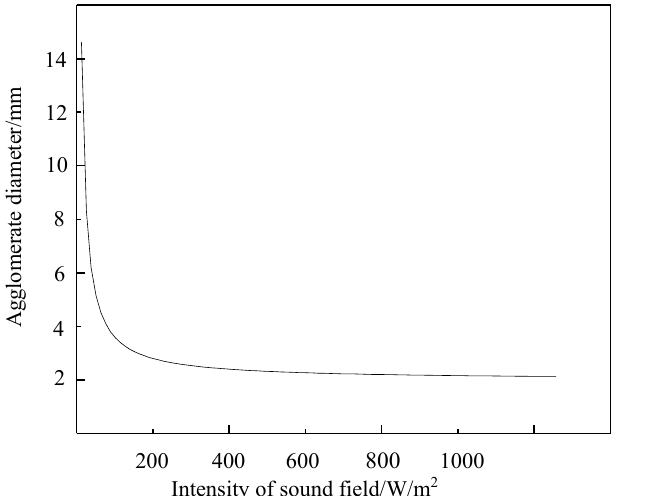
Figure 19. The relation between the intensity of the sound field and the diameter of the agglomeration. The fluidization of iron ore powder is consistent with Equation